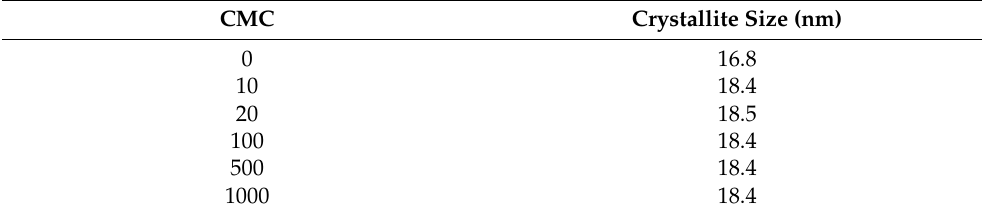
Table 1. Crystallite size of biphasic calcium phosphate prepared by cuttlebone with a variation of the CMC of L-rhamnose monohydrate biosurfactant.